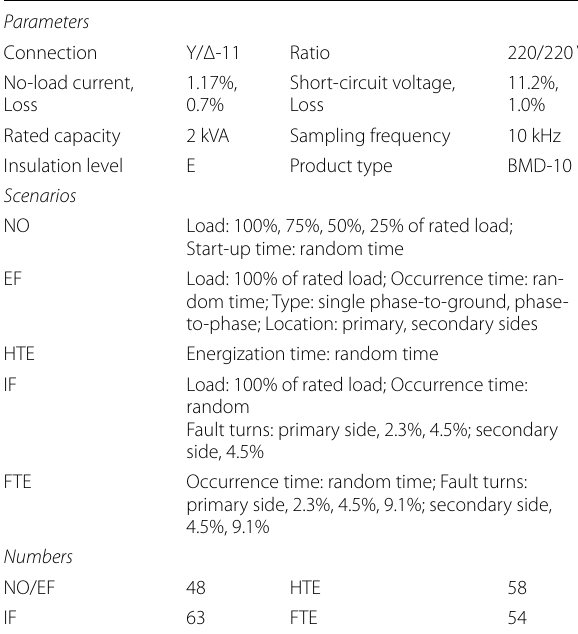
Table 7 Test samples in